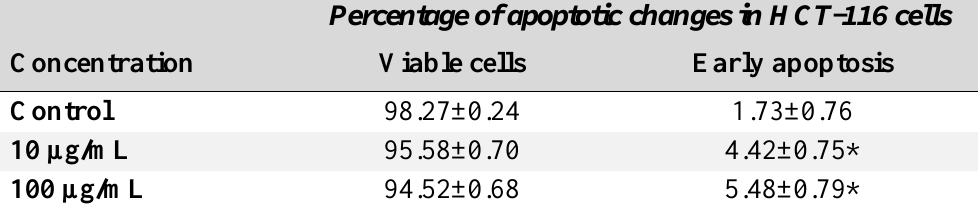
Table 2. The effect of O. minimum on the percentage of viable and early apoptotic changes on HCT-116 colorectal carcinoma cells, after 24 h of applied treatment. The results are presented as the mean of two independent experiments ± standard